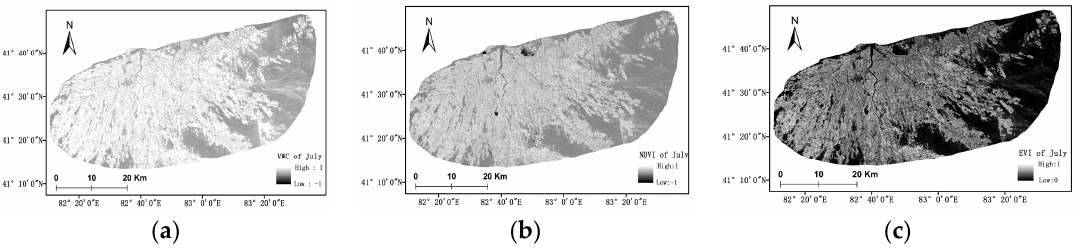
Figure 5. Three vegetation indices retrieval in July. ( a ) Vegetation Water Content (VWC); ( b ) Normalized Difference Vegetation Index (NDVI); ( c ) Enhanced Vegetation Index (EVI). Remote Sens. 2020 , 12 , 1358 11 of 20